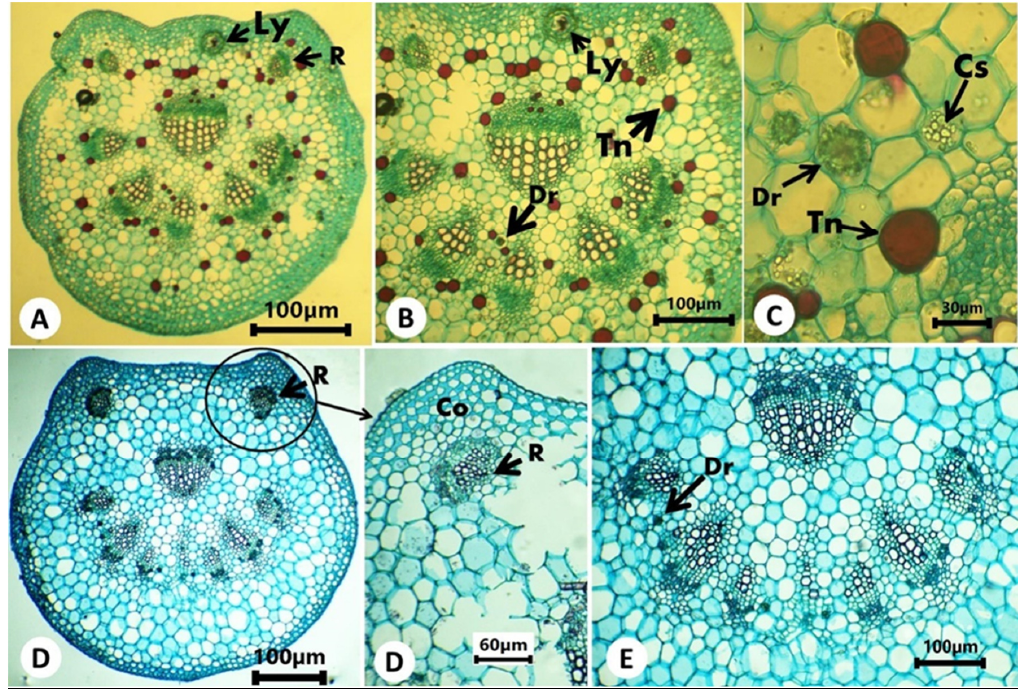
Figure 4. Transverse sections of petiole of Adenia species (A – C) A. cissampeloides and (D – E) A. lobata R = rib trace, Dr = solitary crystal, Tn = tanniferous cell, Ly = lysigenous cavity, Cs = crystal